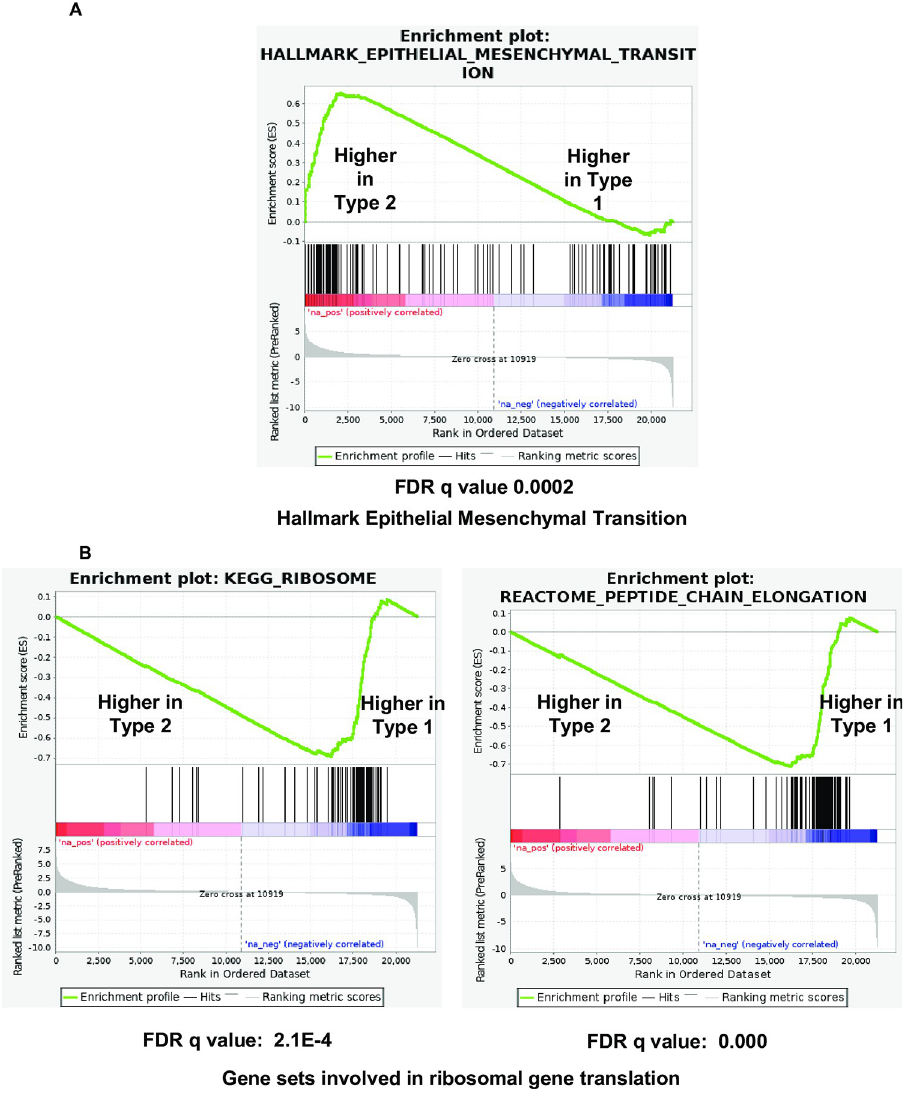
Fig 5. Gene set enrichment analysis (GSEA) suggests increased EMT in Type 2 LCLs. (A) GSEA plot for “Hallmark mesenchymal epithelial cell transition.” (B). GSEA plots for “KEGG_RIBOSOME” and “REACTOME_PEPTIDE_CHAIN_ELONGATION”. seq transcript for each gene in various different T1 versus T2 LCLs are shown in S1 Table and the protein levels are shown in S1 Fig . Of note, the confirmatory western blot experiments were often performed using independently generated (different) EBV lines than those used to obtain the original RNA-seq results. Although the protein results for each gene are largely compatible with the RNA-seq results, the occasional differences observed in certain T1 or T2 lines likely reflects both the difficulty in obtaining adequate protein from very early passage LCLs (particularly T2 LCLs) to perform the various different western blot analyses shown, as well as the selection pressure for T2 LCLs to become more similar to T1 LCLs as they are con- tinually passaged in culture.